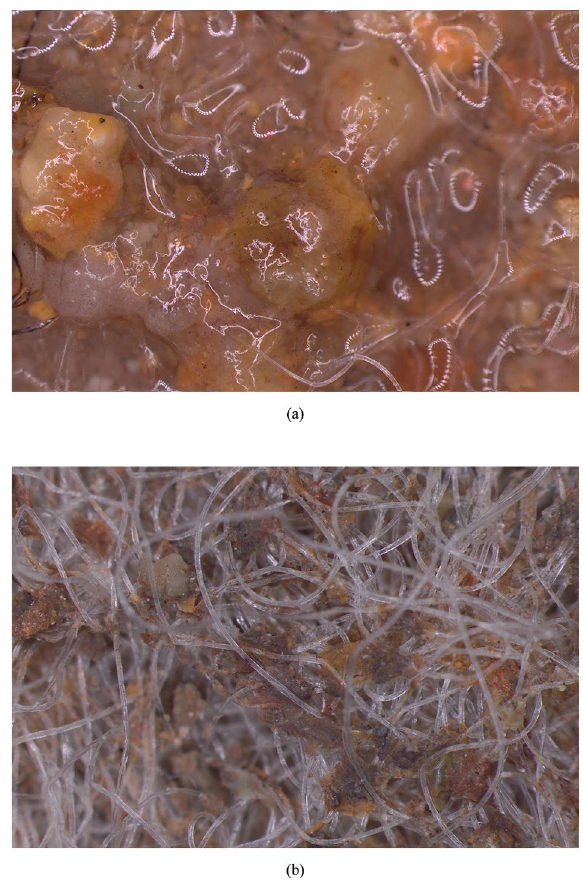
Figure 12. Images of tested GCL surface after saturated shear tests taken at 20× magnification ( a ) bentonite extrusion under hydration, ( b ) extruded bentonite after drying up the